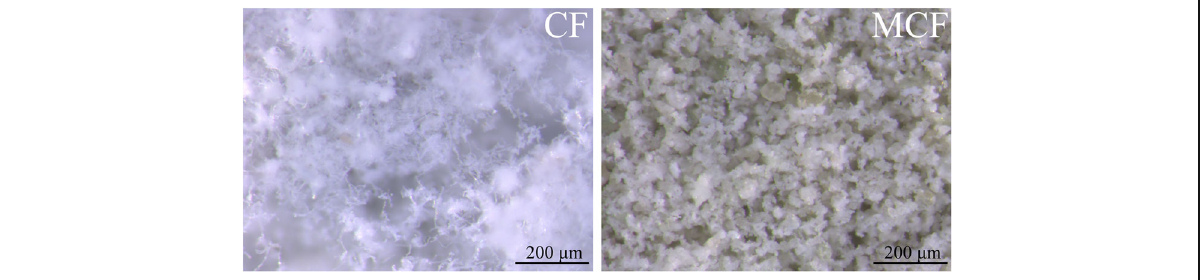
Fig. 6 The SM photos of CF and